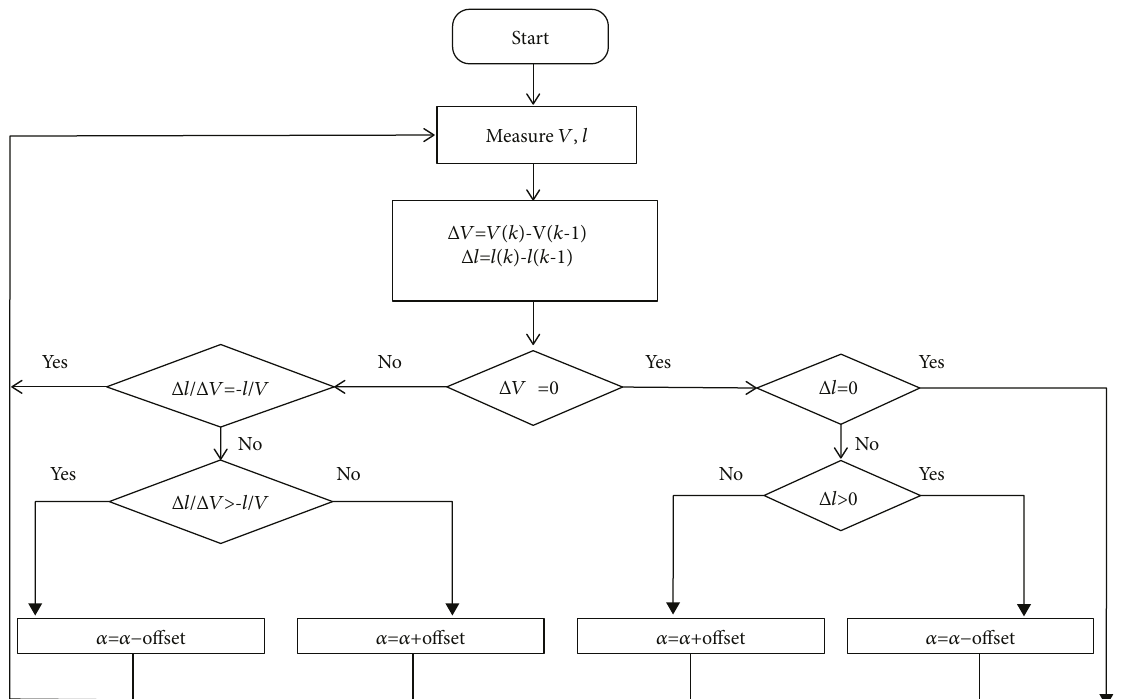
Figure 19: Flowchart of INC